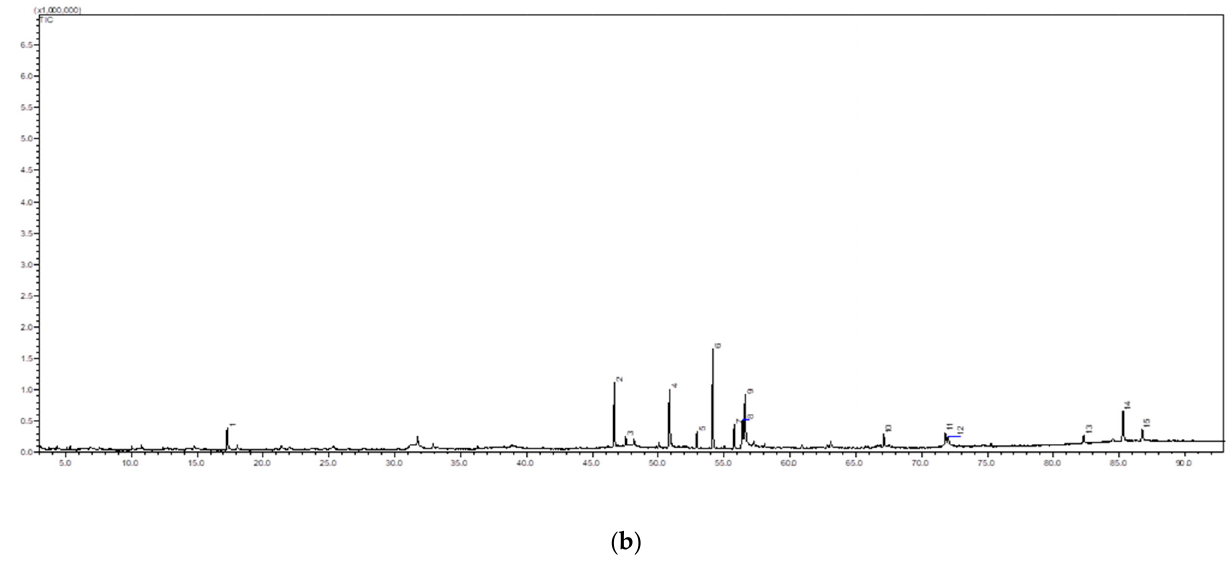
Figure 6. GC-MS chromatogram of fresh-cut pennywort leaves using ethanolic extract ( a ) control, ( b ) PL-treated sample. Table 2. Major constituents of fresh-cut pennywort leaves using ethanolic extract in GC-MS chro- matogram ( a ) control, ( b ) PL-treated sample. (a) Peak Functional Molecular For- Name of Compound No. Compound